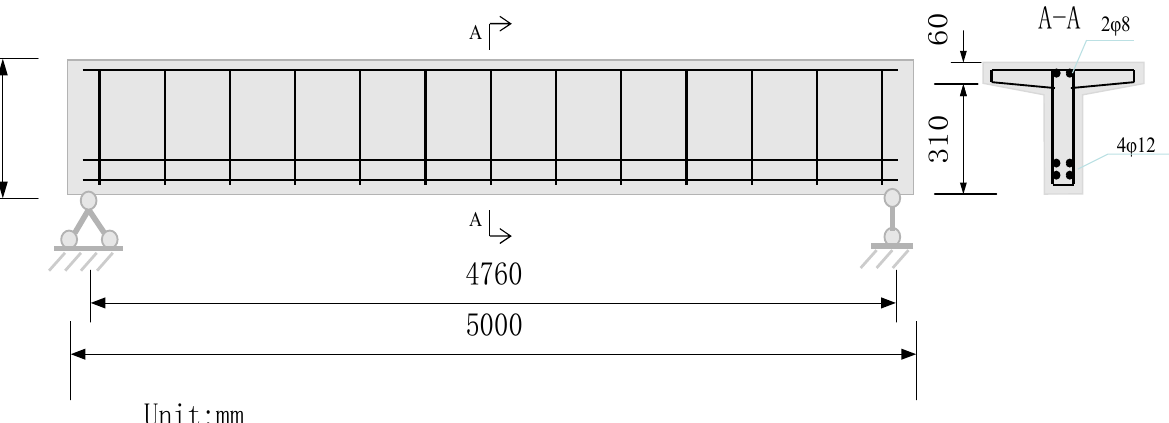
Figure 1. Dimensions and reinforcement arrangement of the concrete T-beam.